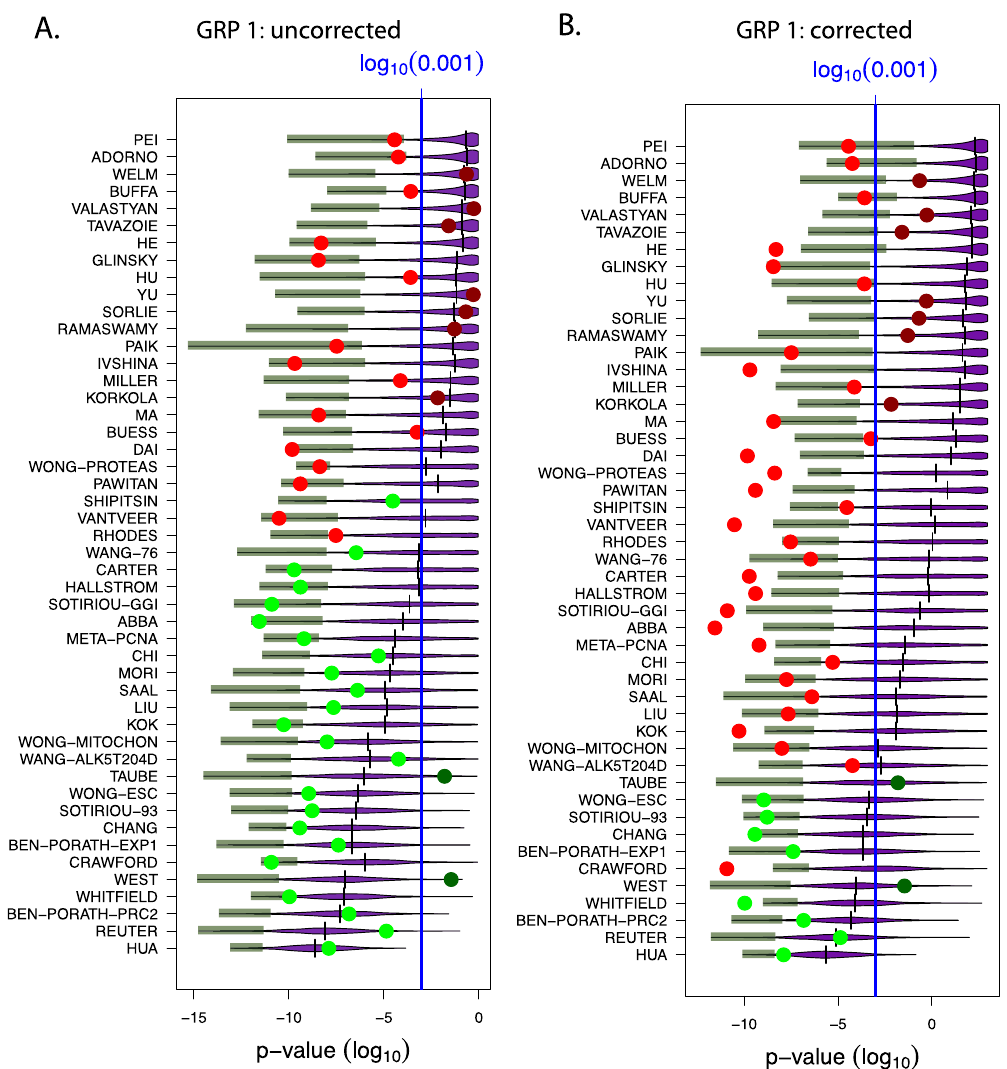
Figure 4. Results for gene removal procedure 1 for the NKI data. Shown are prognostic prediction capabilities of surrogate gene sets for 48 studies after removing BM signatures. Left: Results for uncorrected p-values (as in the original study 17 ). Right: Bonferroni corrected